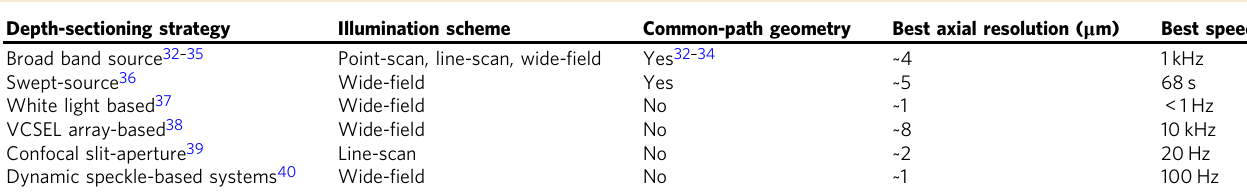
Table 1 Summary of depth-resolved re fl ectance QPM systems Depth-sectioning